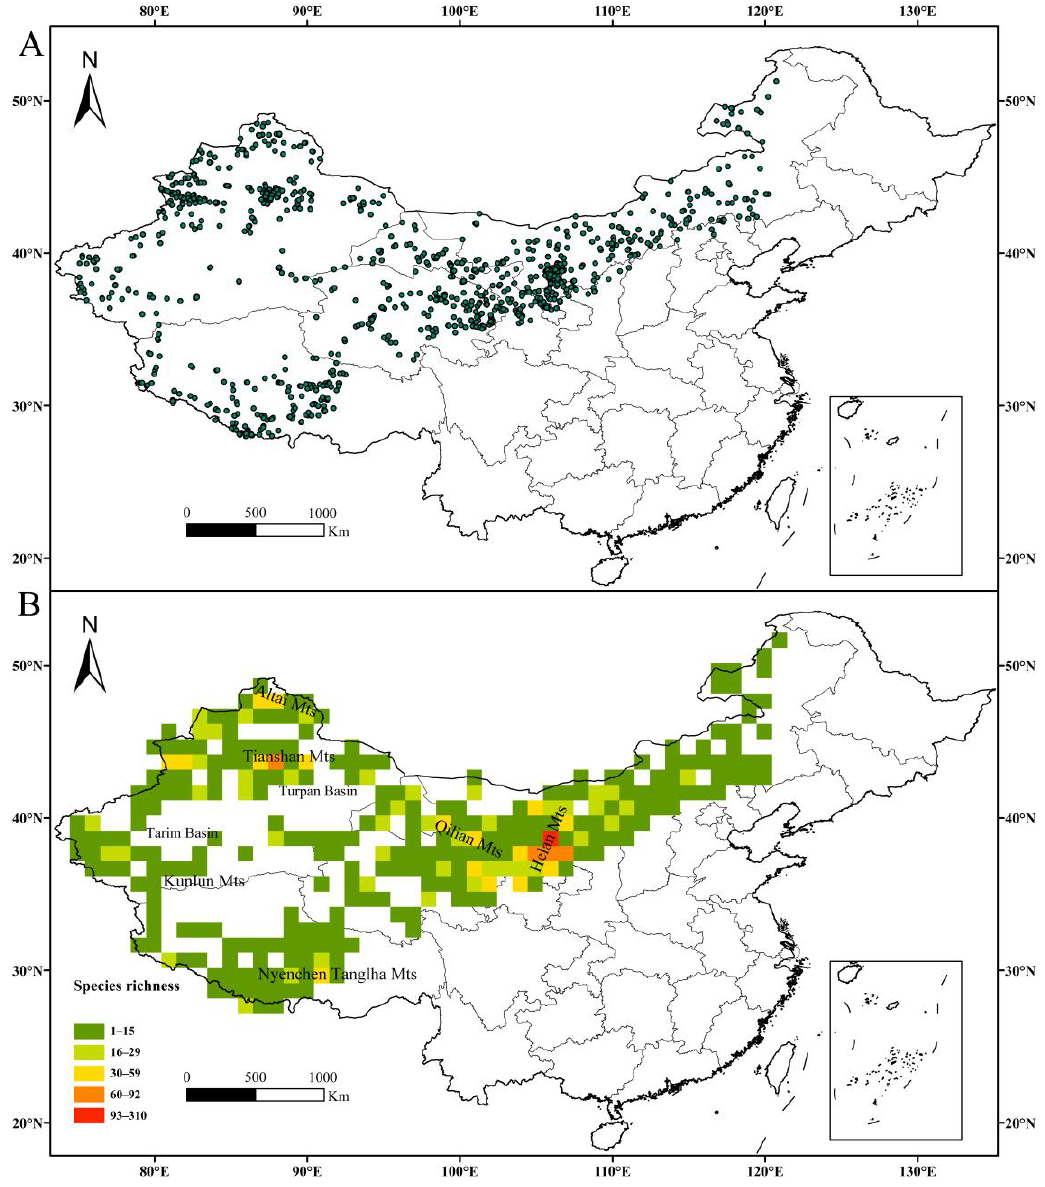
Figure 3. ( A ) Distribution records and ( B ) species richness patterns in 1° grid size of Tenebrionidae in arid and semiarid areas of China.